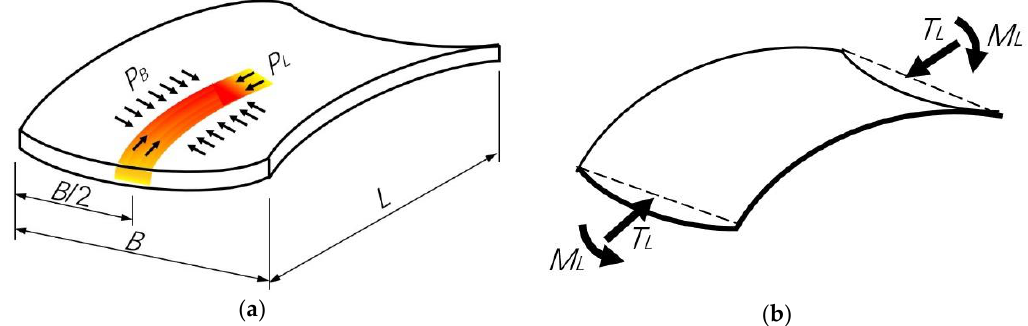
Figure 4. Induction coil heating deformation analysis of the experiment: ( a ) local heating contraction force and ( b ) effect of the resultant force of contractions along the L direction.